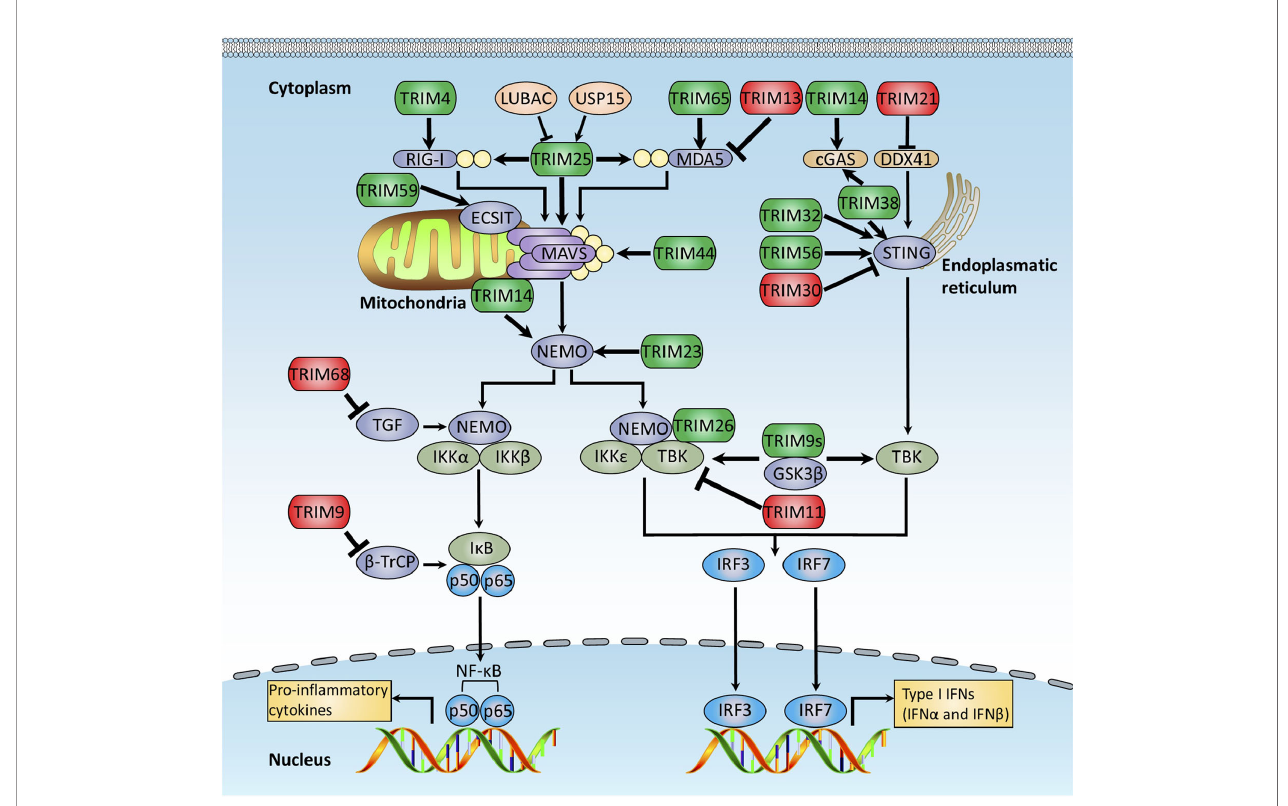
FIGURE 3 | TRIMs regulate RLRs and cytosolic DNA-sensing receptor pathways. The RLRs and cytosolic DNA-sensing receptor pathways regulated by TRIM proteins. RLRs are crucial cytoplasmic PRRs that are responsible for recognition of RNA virus infections, whereas cytosolic DNA-sensing receptors recognize host and microbial DNA in the cytosolic. They both fi nally activate NF- k B and IRFs to induce the production of proin fl ammatory cytokines and type I IFNs. This fi gure illustrates TRIM proteins that modulate RLRs and cytosolic DNA-sensing receptor signaling pathways, and the details of the modulation mechanisms are described in the text. TRIMs promoting RLRs and cytosolic DNA-sensing signaling pathways are indicated in green, whereas these exerting the opposite functions are indicated in